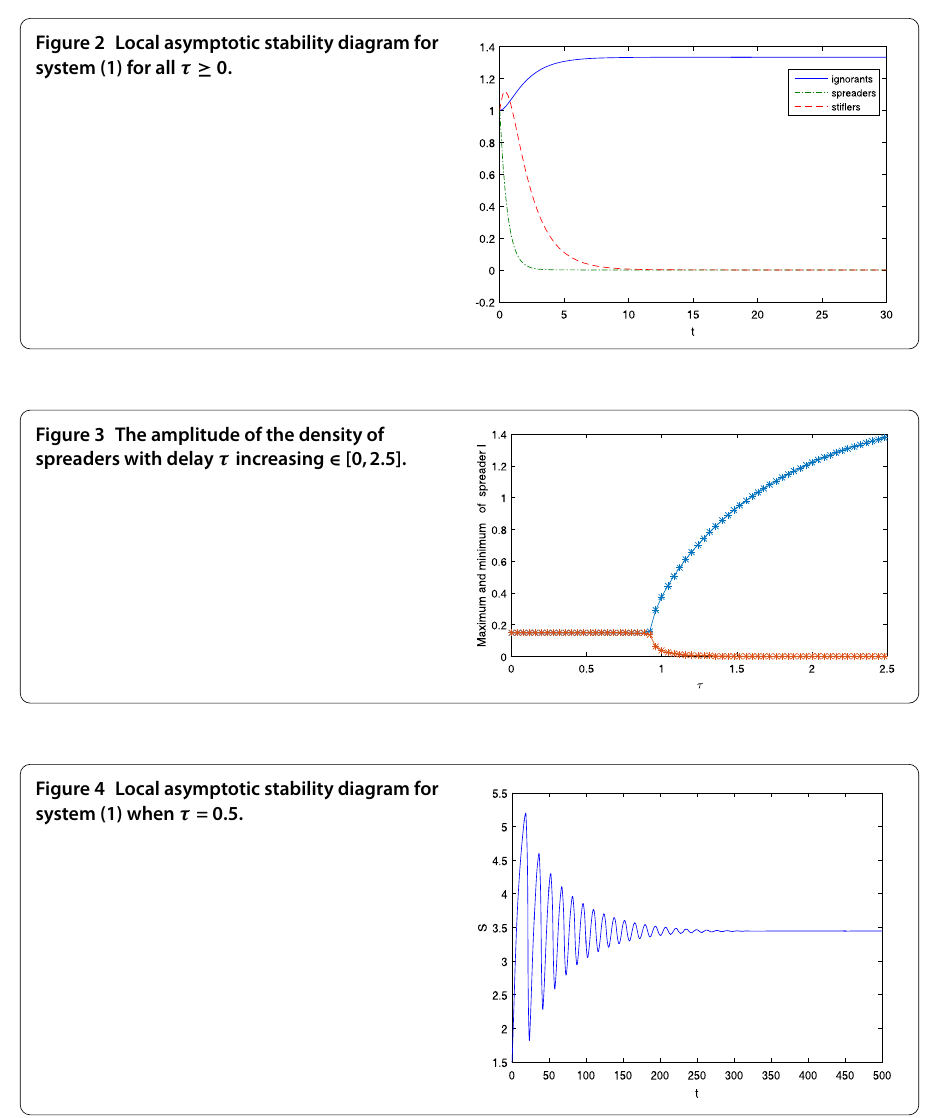
Figure 2 Local asymptotic stability diagram for system (1) for all τ ≥ 0.